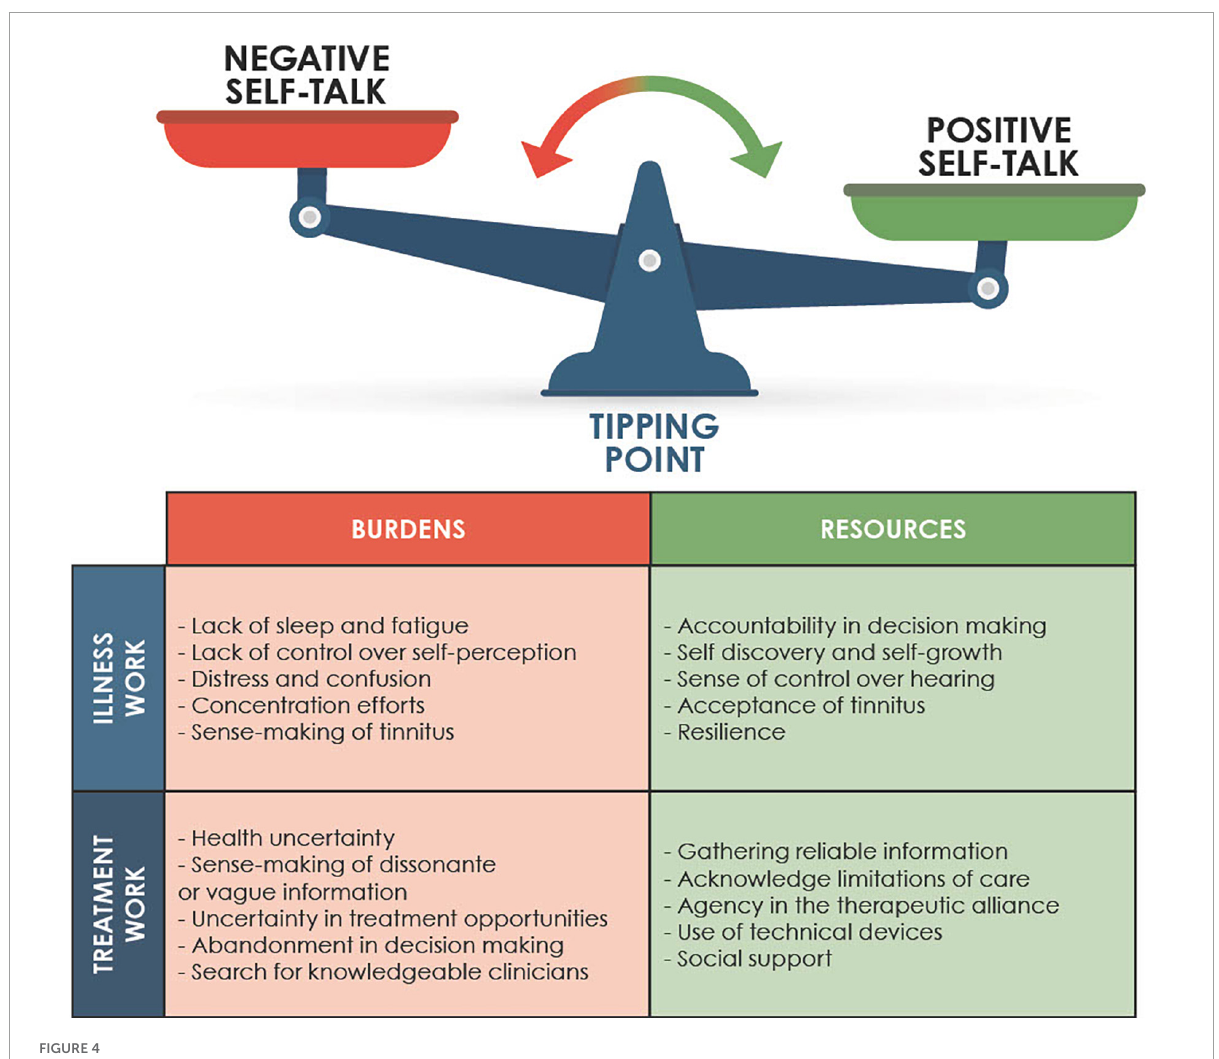
FIGURE4 Application of burden of care theory to the thematic